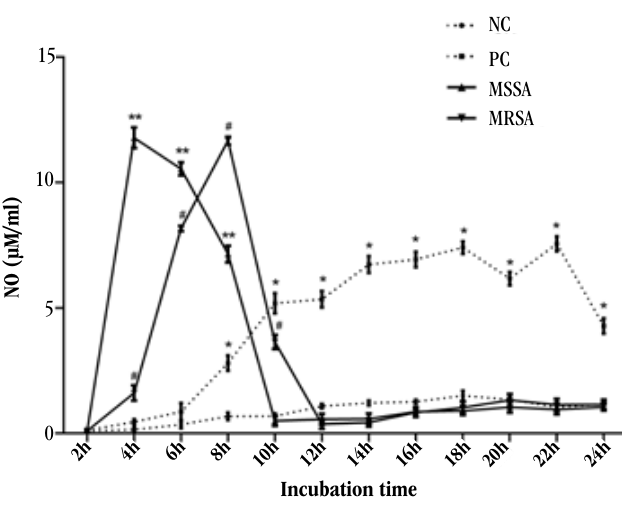
figurE 4 – Kinetics of NO production by alveolar macrophages from adult Wistar rats for NC, PC, MSSA and MRSA systems. Values expressed as mean ± standard error ( n = 20)